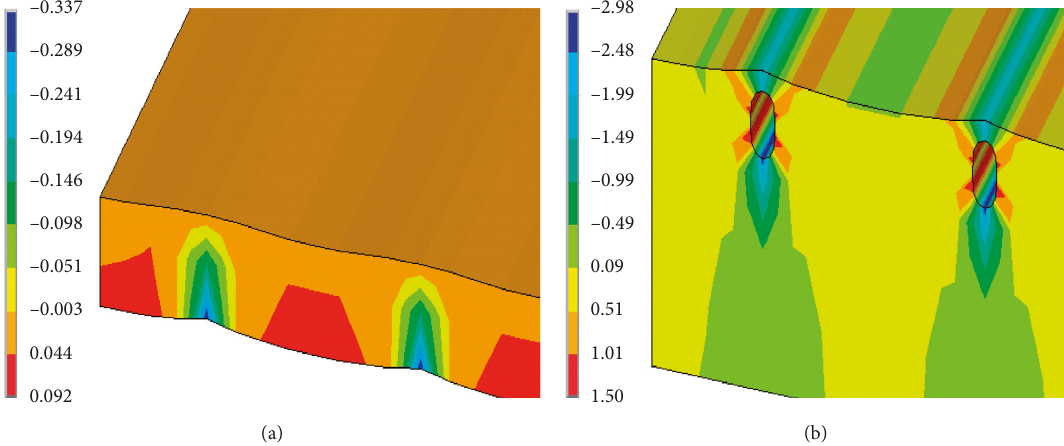
Figure 16: Maximum principle stress distribution (MPa) of HSMP with fluid circulation: (a) AL; (b) CL.